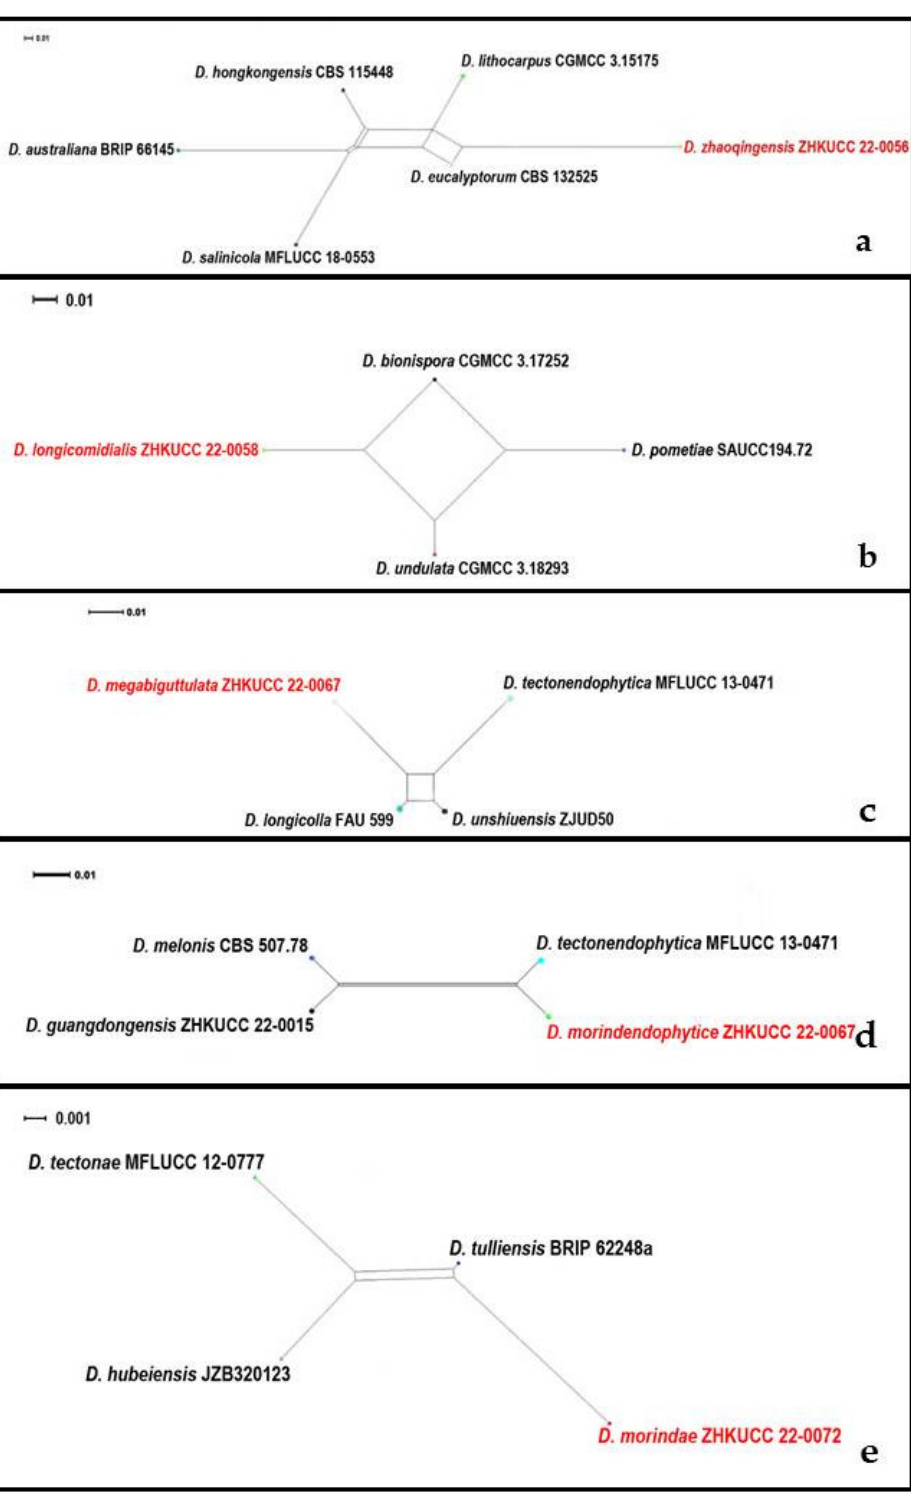
Figure 3. Split graphs showing the results of Pairwise homoplasy index test of ( a ) Diaporthe zhaoqingensis (Fw = 0.550), ( b ) Diaporthe longiconidialis (Fw = 0.300), ( c ) Diaporthe megabiguttulata (Fw = 1.000), ( d ) Diaporthe morindendophytica (Fw = 0.205), ( e ) Diaporthe morindae (Fw = 0.238) with their most closely related species using Log-Det transformation and splits decomposition options. The new taxon in each graph is shown in bold font.